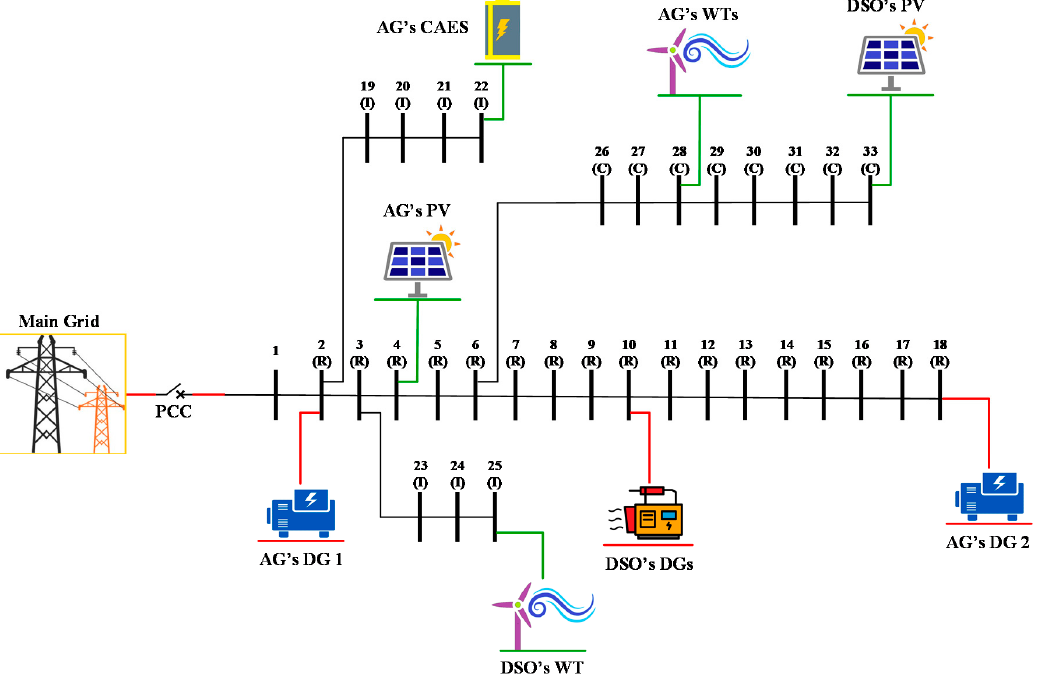
Figure 4. Configuration of the modified 33-Bus SDN.